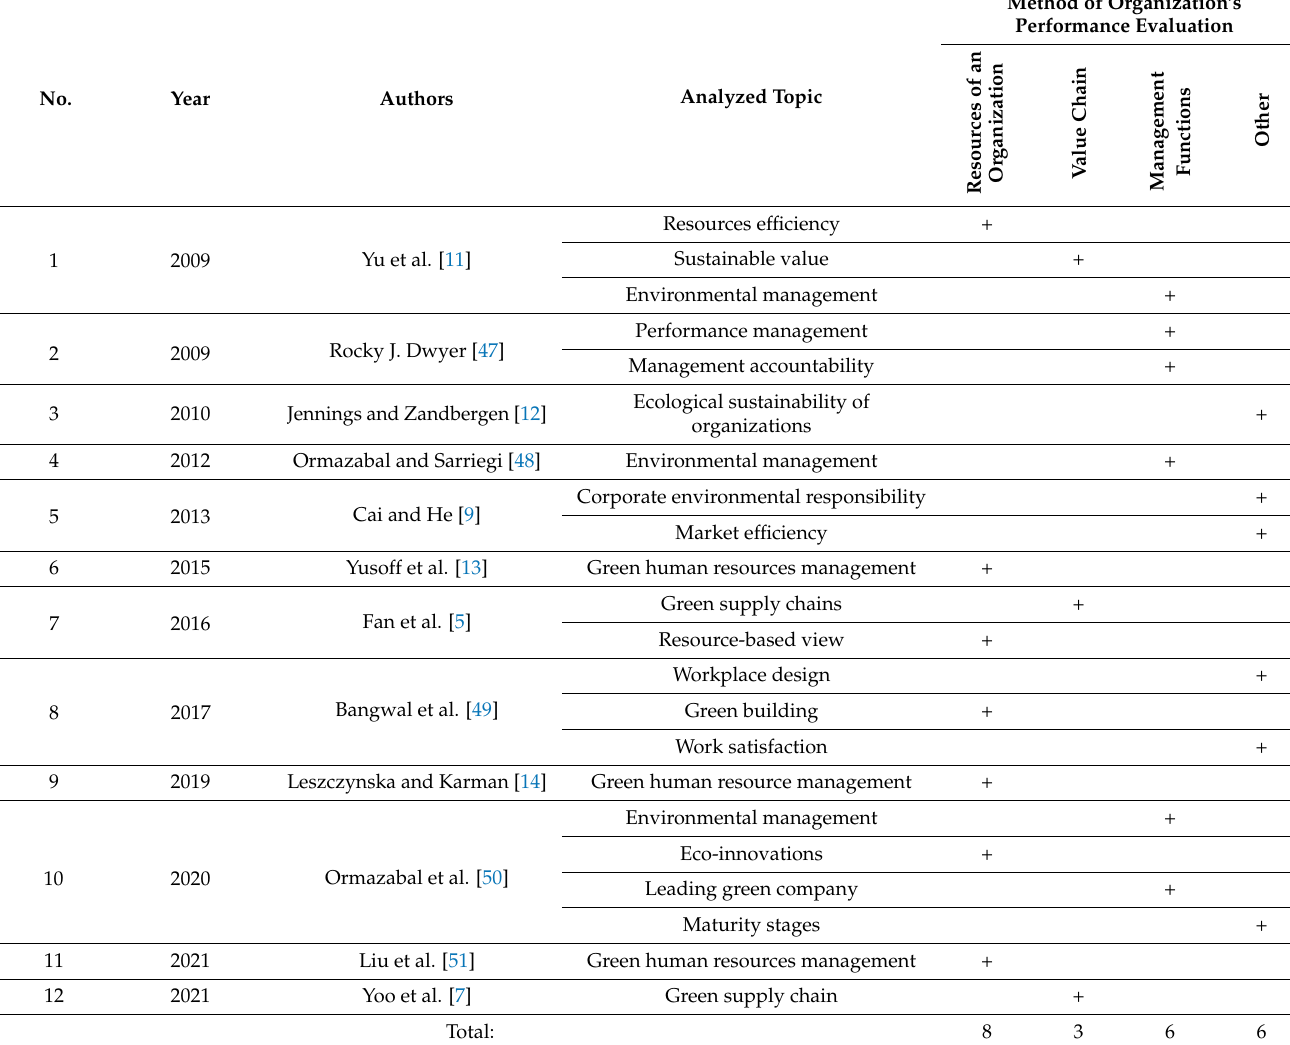
Table 3. Determining the suitable approaches to analyzing a green organization’s